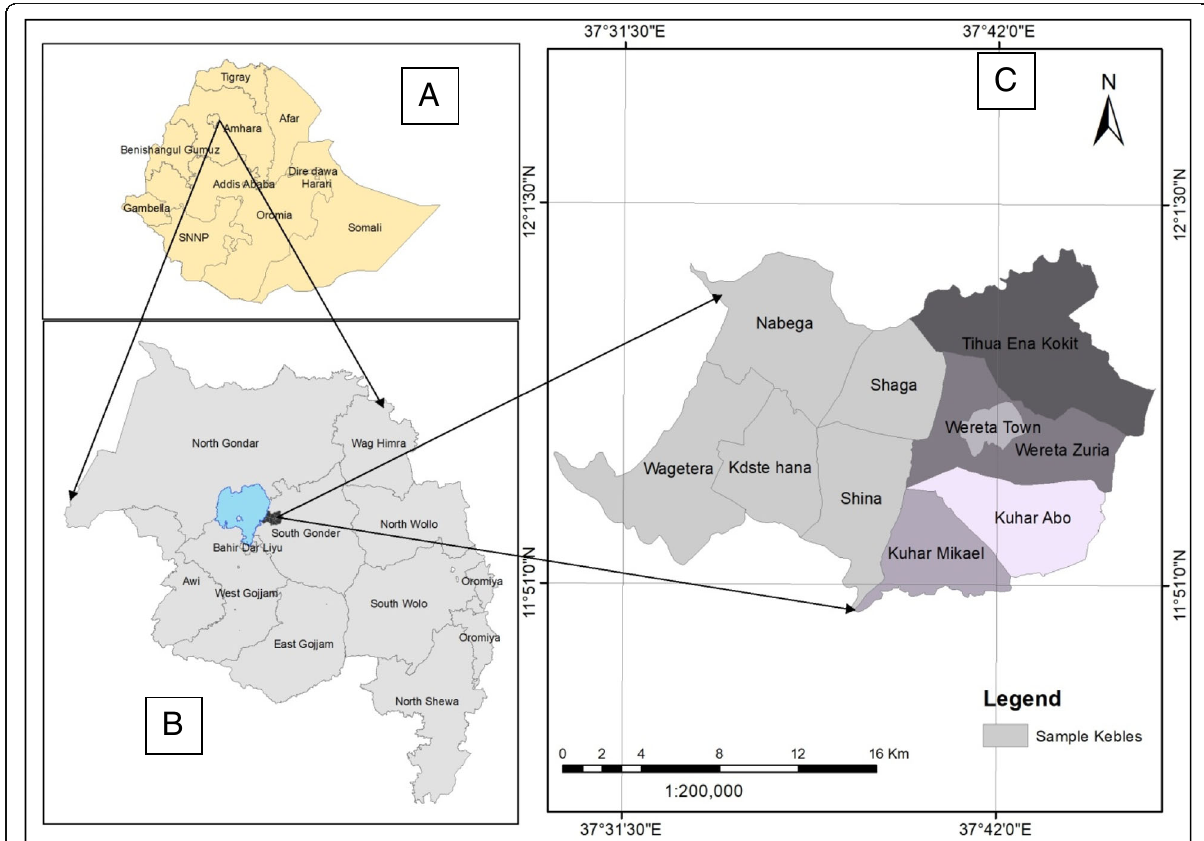
Fig. 1 Map of the study district including under biosphere reserve. The top figure ( A ) in the left shows the map of Ethiopia with regional boundaries and the bottom figure ( B ) in the left shows the Amhara region where the BR and Lake Tana are located. The figure ( C ) in right shows the districts of Fogera and study sample